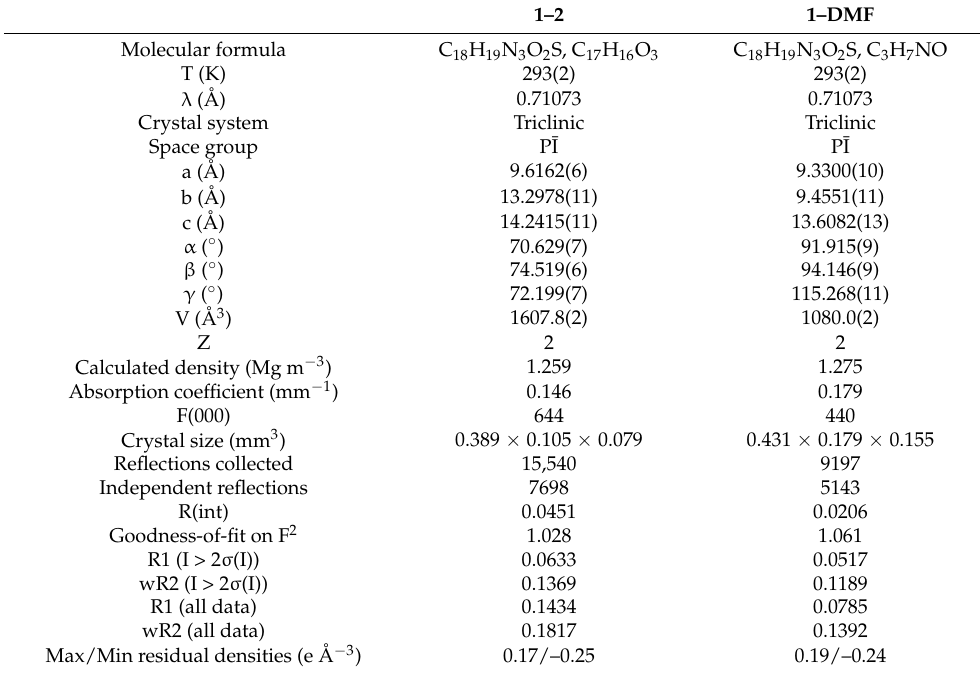
Table 1. Crystal and structure refinement data for 1 – 2 and 1